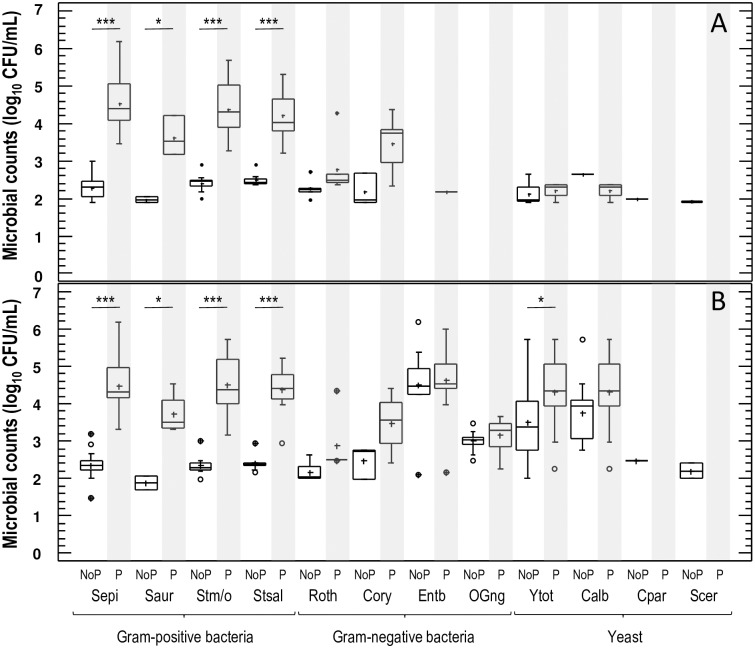
Microbial counts of milk samples obtained after milk extraction by manual expression (panel A) or pumping (panel B).Samples from women without painful breastfeeding are marked as "NoP" at the bottom of the figure while samples from women with painful breastfeeding are marked as "P" at the bottom of the figure and are shaded in grey. Abbreviations: Sepi, Staphylococcus epidermidis; Saur, Staphylococcus aureus; Stm/o, Streptococcus mitis/oralis; Stsal, Streptococcus salivarius; Roth, genus Rothia; Cory, genus Corynebacterium; Entb, Enterobacteriaceae; Ogneg, otherGram-negativebacteria; Ytot, yeasts (total); Calb, Candida albicans; Cpar, Candida parapsilosis; Scer, Saccharomyces cerevisiae. *, P<0.05; ***, P<0.001.